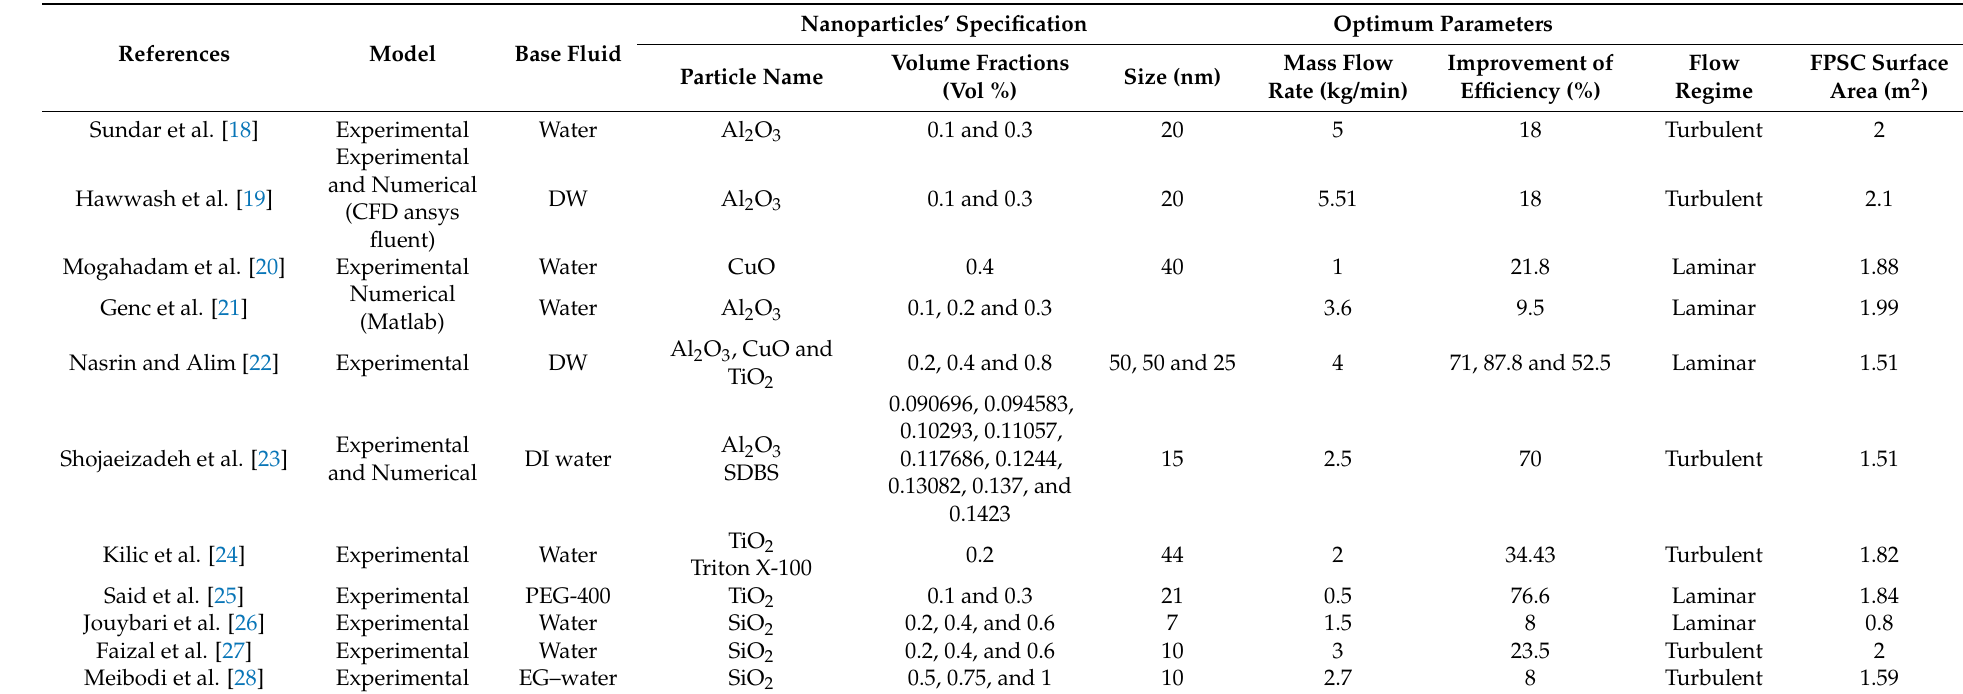
Table 1. Literature review summary on FPSC using